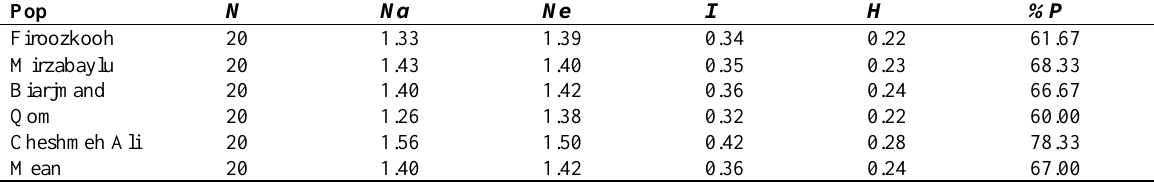
was observed in Cheshmeh Ali I = 0.42, H = 0.28) and Qom populations ( I = 0.32, H = 0.22), respectively. Comparing Nei’s genetic distances between pairs of populations showed that the lowest genetic distance was between Qom and Biarjmand populations (0.047) and the highest genetic distance was between Qom and Firoozkooh populations (0.176) (Table 4). The hierarchical AMOVA revealed that the major variance component (73%) was observed within the populations while only 27% variance was reflected among the populations. Both variance components proved highly significant values ( p < 0 . 001) (Table 5).